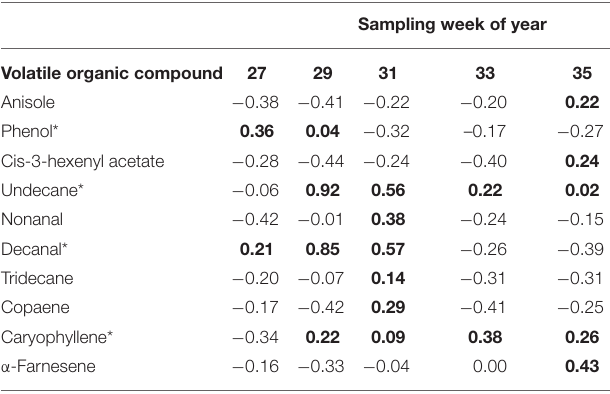
TABLE 3 | Correlation values ( r ) comparing relative abundance.